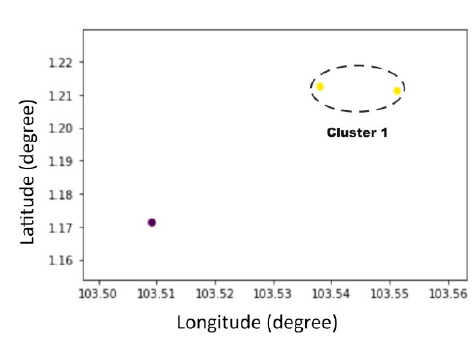
Figure 9. Result of DBSCAN at 1810.